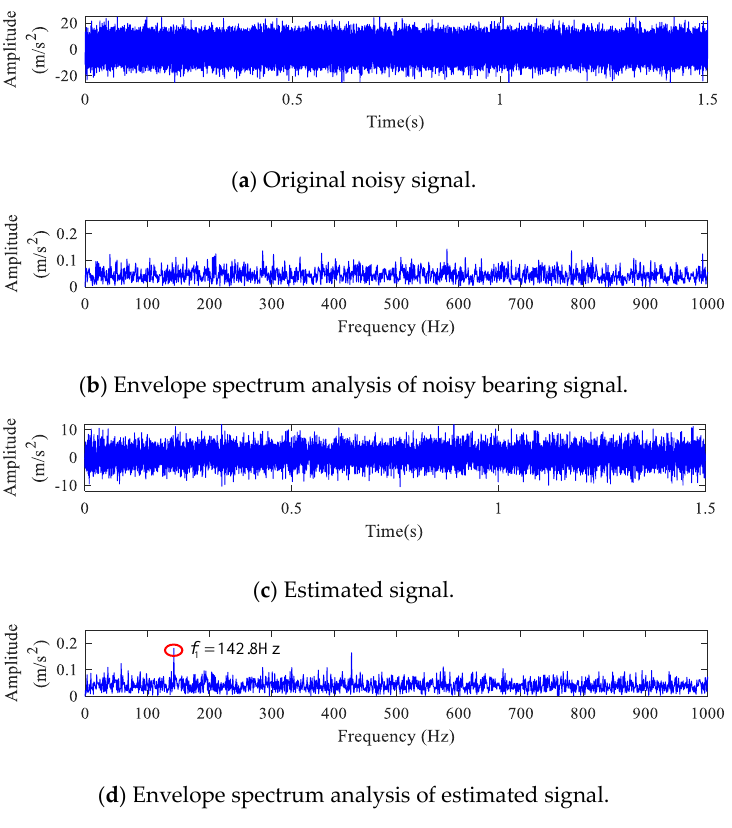
Figure 5. Results of experimental outer race fault signal.